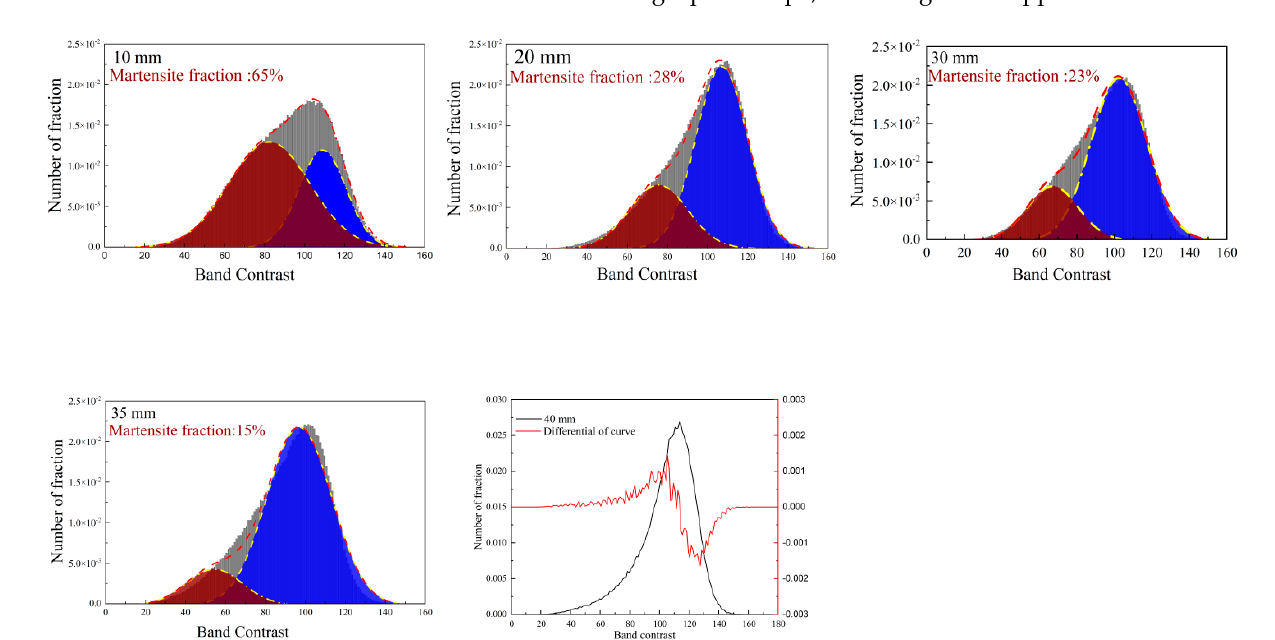
Figure 5. Band contrast value frequency and Gaussian fitting of specimens within 40 mm. The threshold corresponds to the BC curve’s differential extremum. The red colour peak corresponds to martensite and the blue colour to bainite.